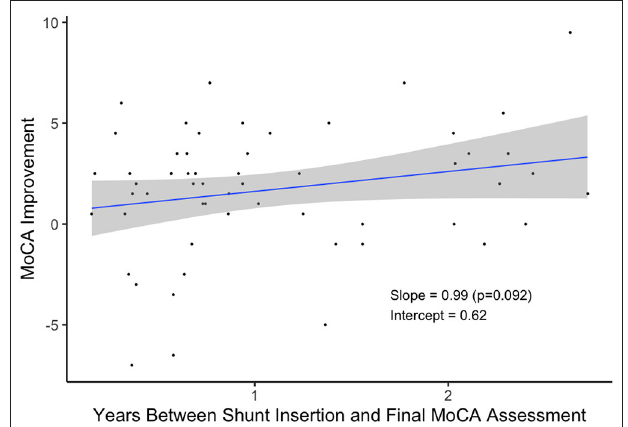
FIGURE 4 | Improvement in MoCA by Time Since Shunt Insertion ( n = 56).